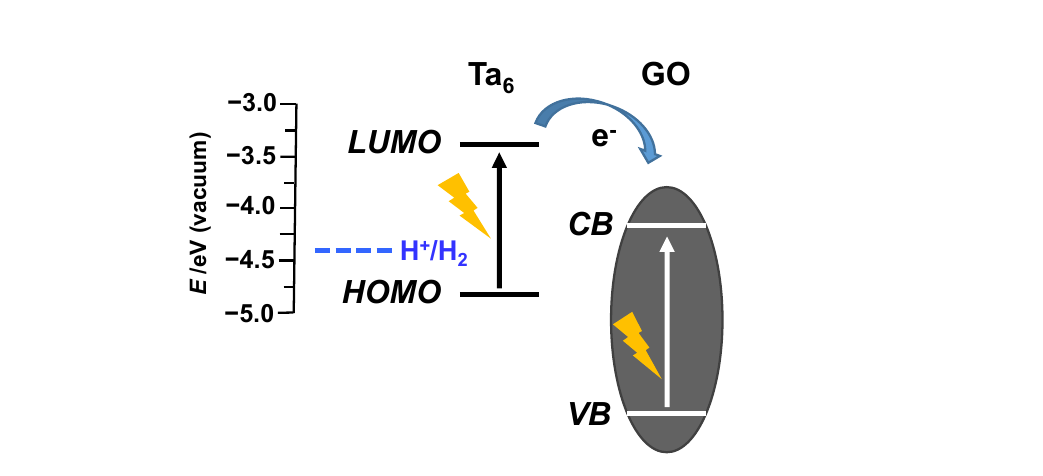
Figure 7. Schematic energy diagram which depicts the electron injection from the LUMO orbitals of [{Ta 6 Br i 12 }(H 2 O) a 6 ] 2+ cluster into the CB of GO.